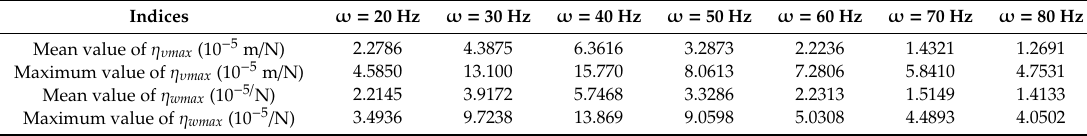
Table3. Meanandmaximumvaluesofbothindicesoverworkspacewithdi ff erentexcitationfrequencies.